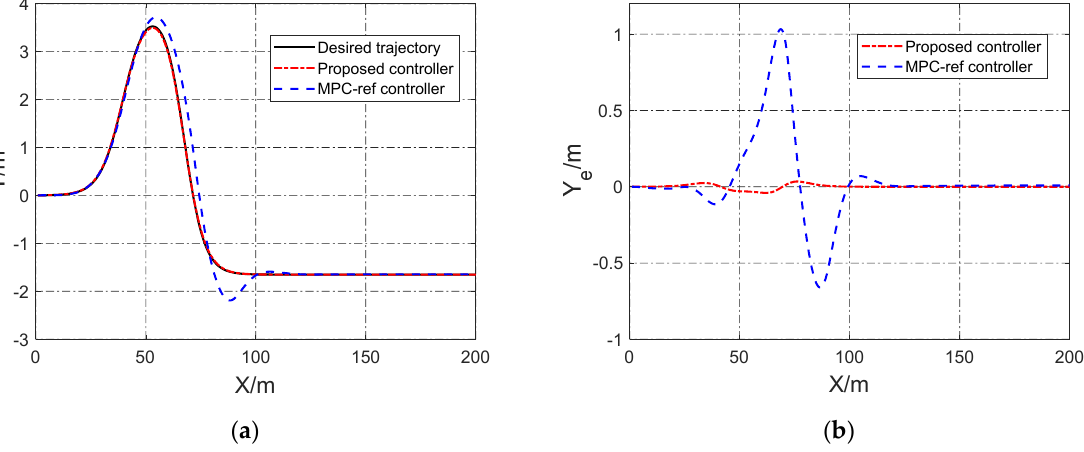
Figure 14. Trajectory tracking results compared to the algorithm proposed at 45 km · h − 1 ; ( a ) Comparison of driving paths; (b) Comparison of lateral errors.